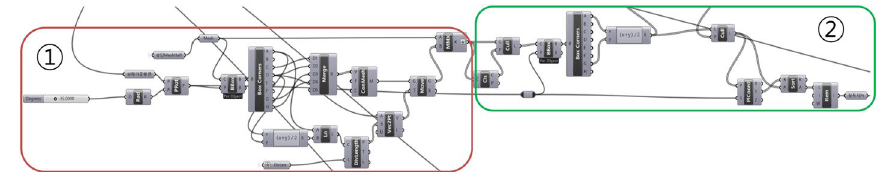
Fig. 12 Bust point setting